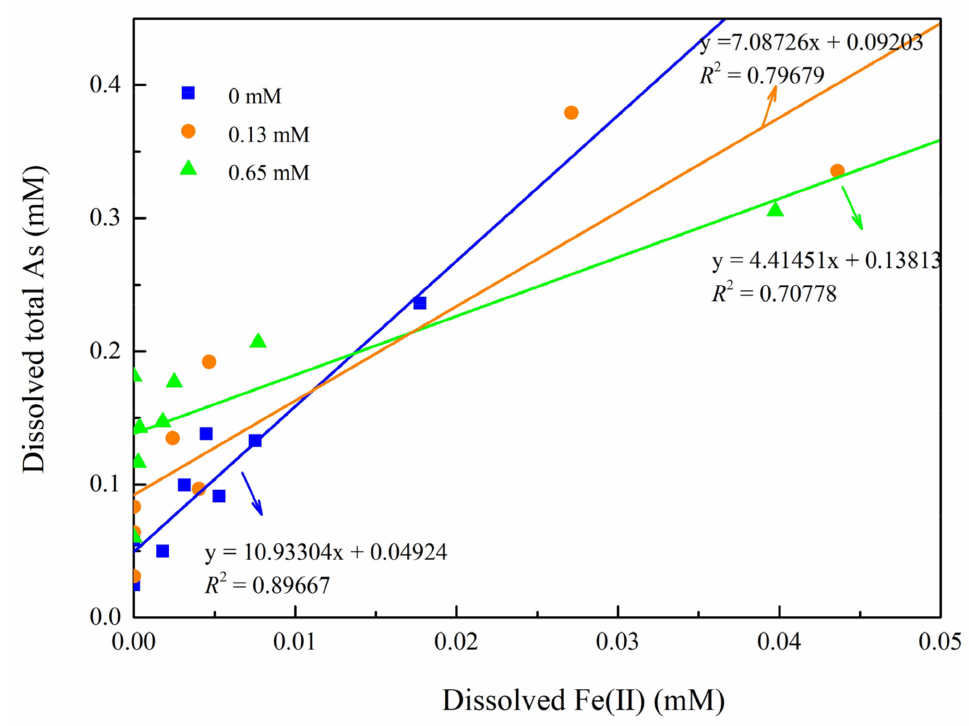
Figure 9. Relationship between dissolved As and Fe(II) for unremediated soil with different phos- phate